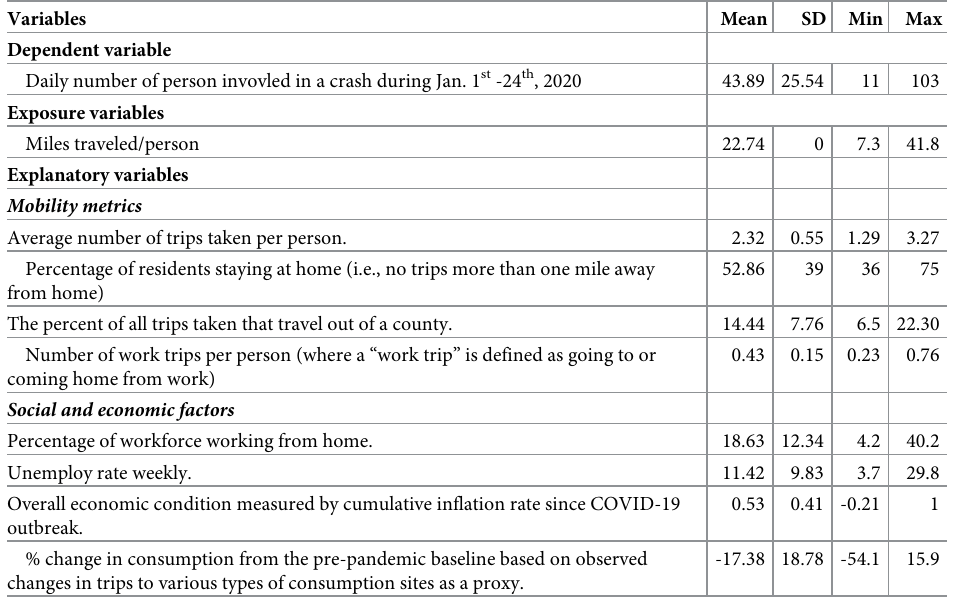
Table 1. Variables considered for the